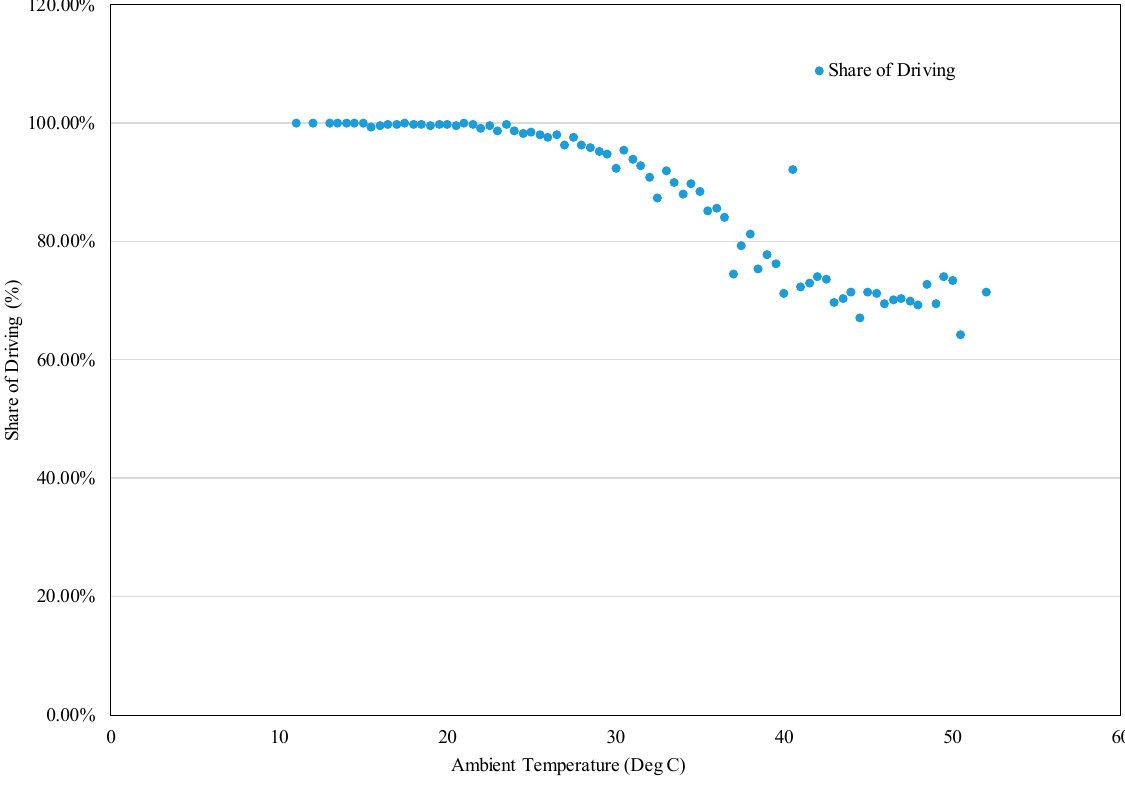
Figure 5. Effect of ambient temperature on the share of energy for driving.